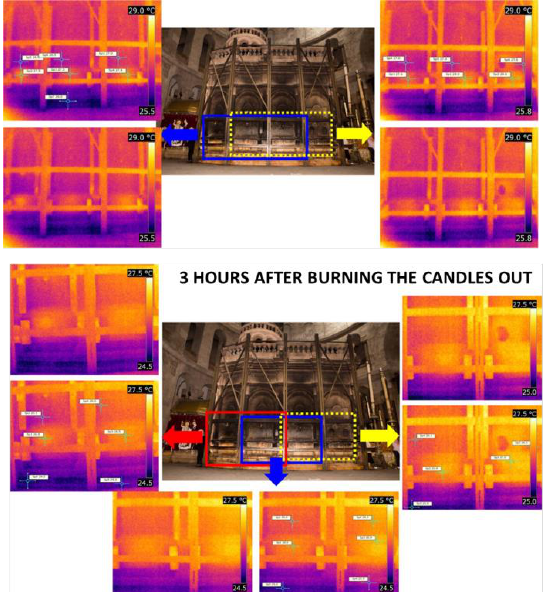
Figure 13: Thermal heterogeneity of the building materials of the Holy Aedicule, at the scale of the monument, assessed by IRT, regarding the effect of candles burning close to the external surfaces